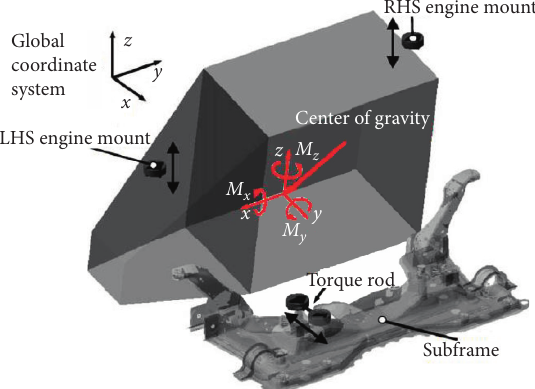
Figure 7: Engine model with engine suspension layout [116]. Table 1: Summary of AEM model and